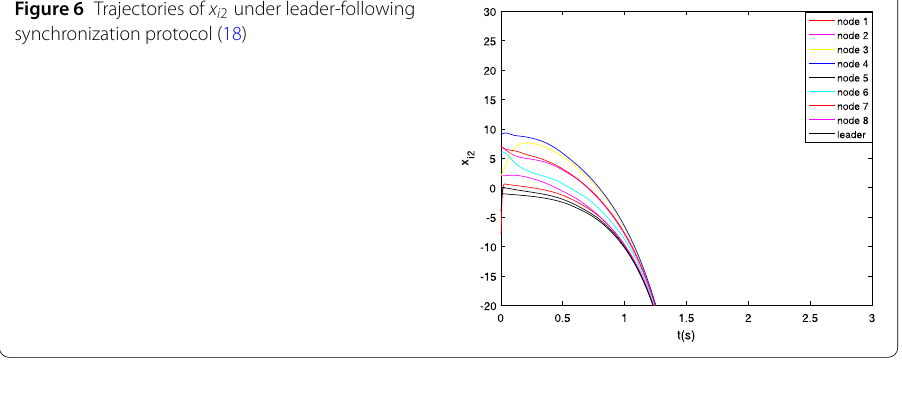
Figure 7 Trajectories of the adaptive parameters in